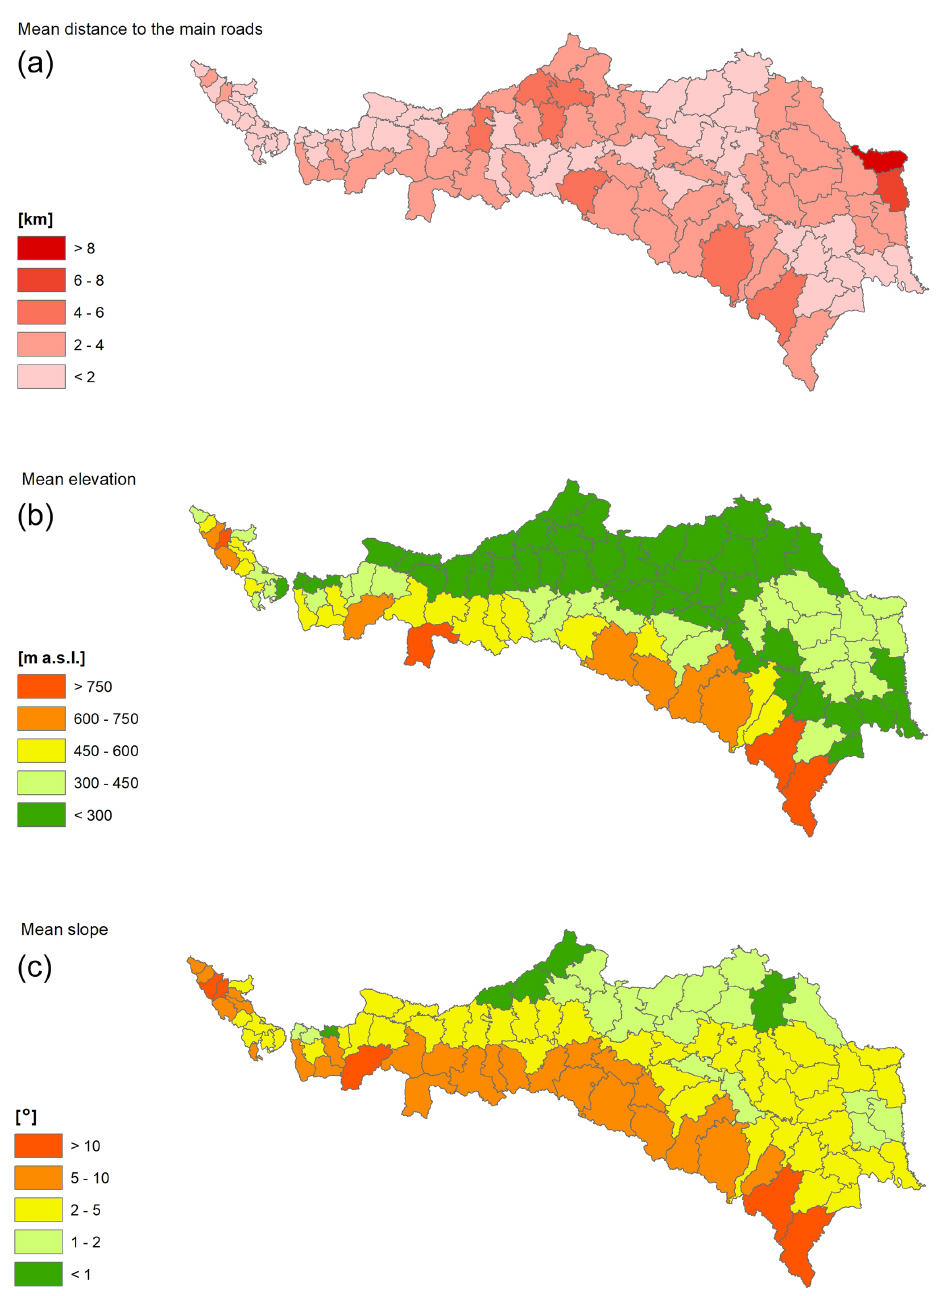
Figure B2. Uncertainty-related variables presented at the district level: mean distance to the main road (a) , mean elevation (b) , and mean slope (c)